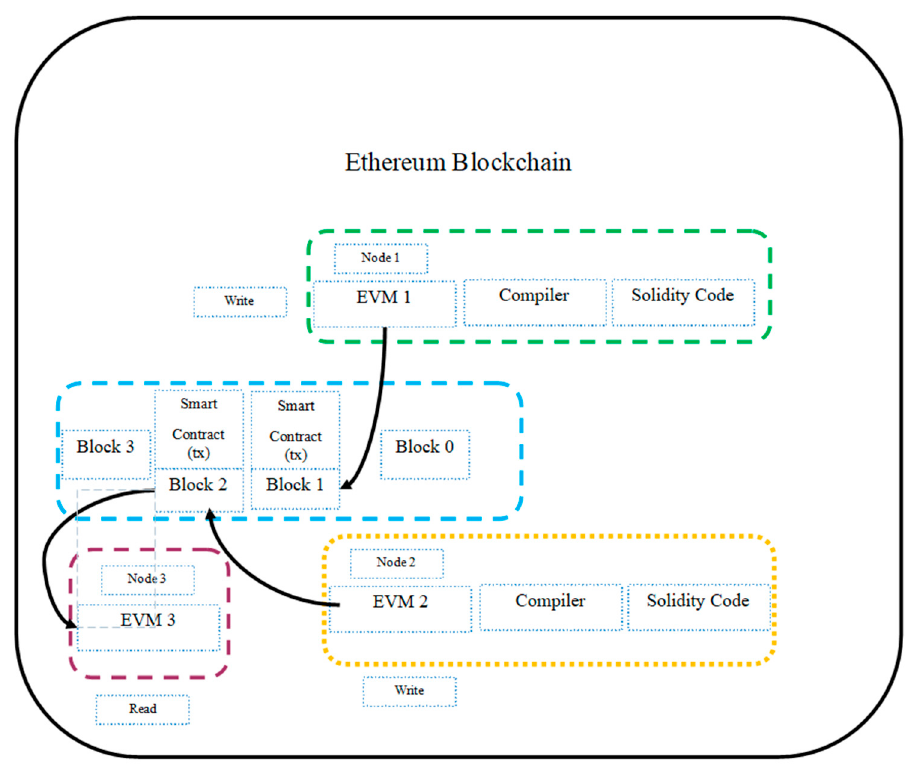
Figure 1. Ethereum Smart Contract Mechanism.